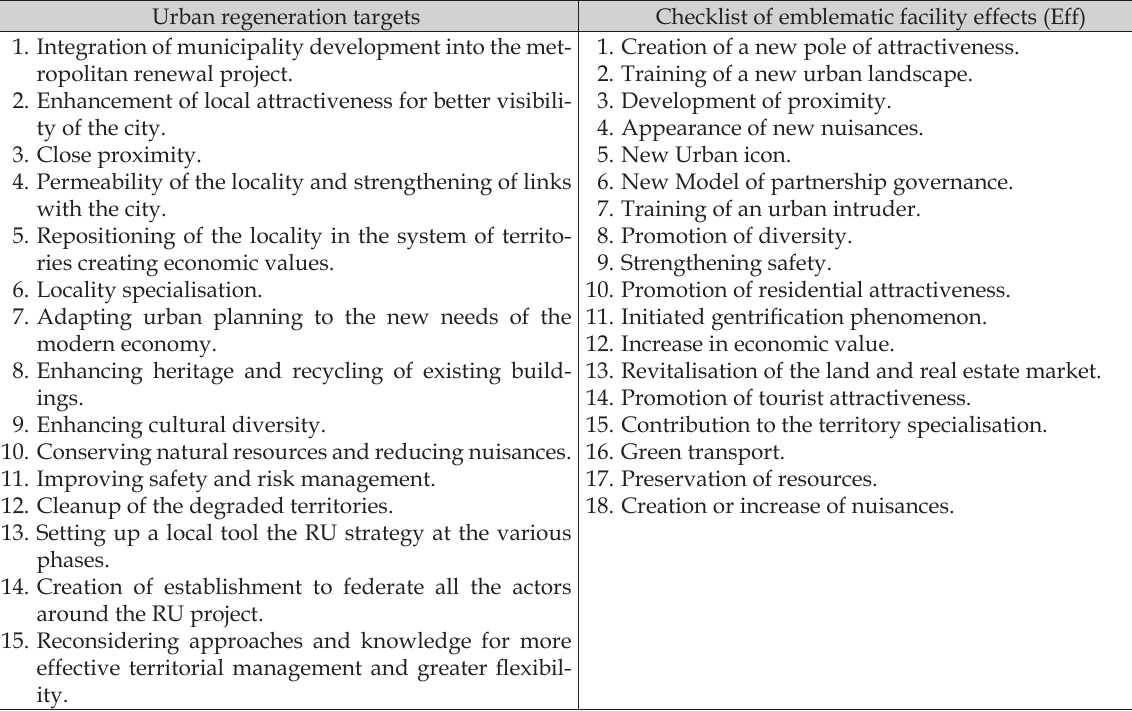
Table 1. Components of the structural